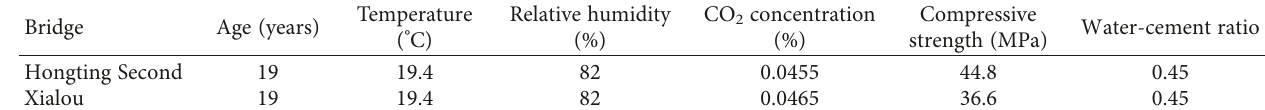
Figure 14: Chloride profile vs. CO 2 concentration according to the proposed model (equations (14a) and (14b)). Table 11: Condition of the Hongting Second bridge and the Xialou bridge.